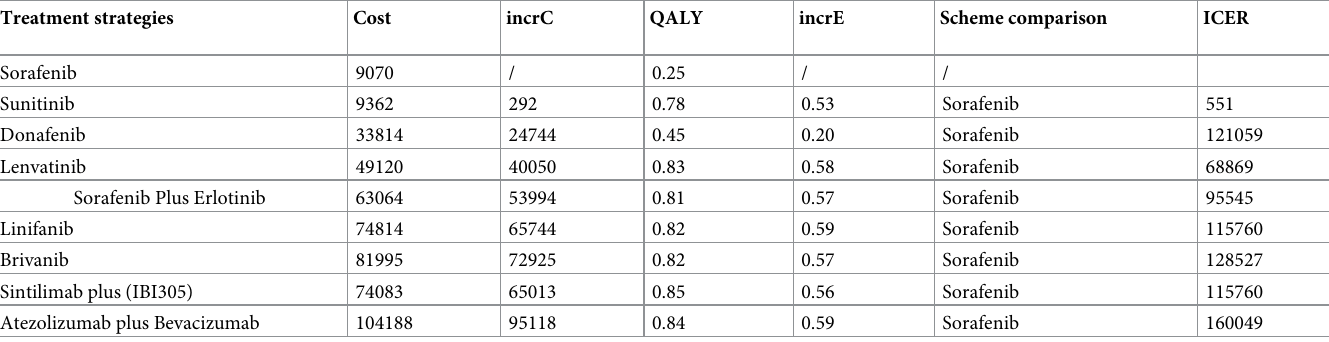
Table 2. Base case results. Treatment strategies